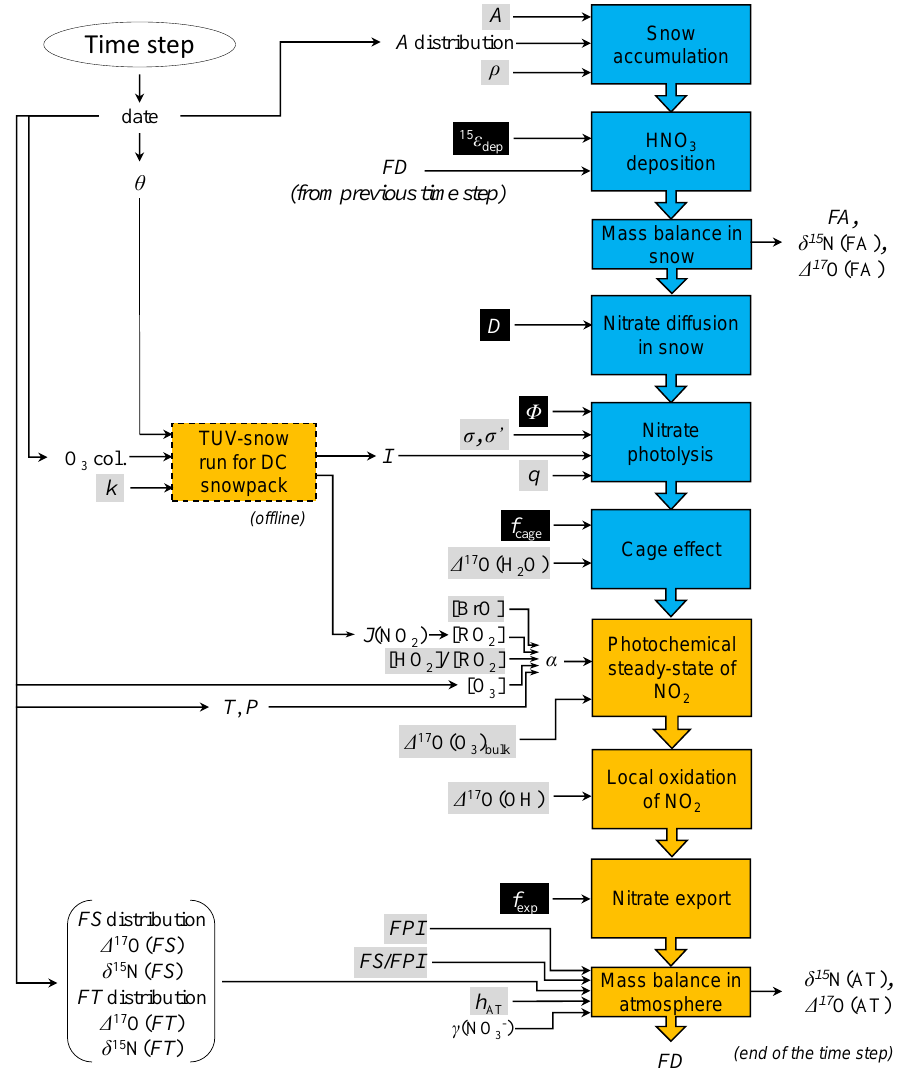
Figure 2. Schematic view of the processes included in TRANSITS (one time step is shown). The orange and blue boxes represent processes occurring in the atmosphere and the snowpack, respectively. Arrows entering from the left and leaving to the right represent inputs and outputs for each process. For the sake of clarity, we only display the input time variables (black font on white background), the fixed parameters (black on grey) and the adjustment parameters (white on